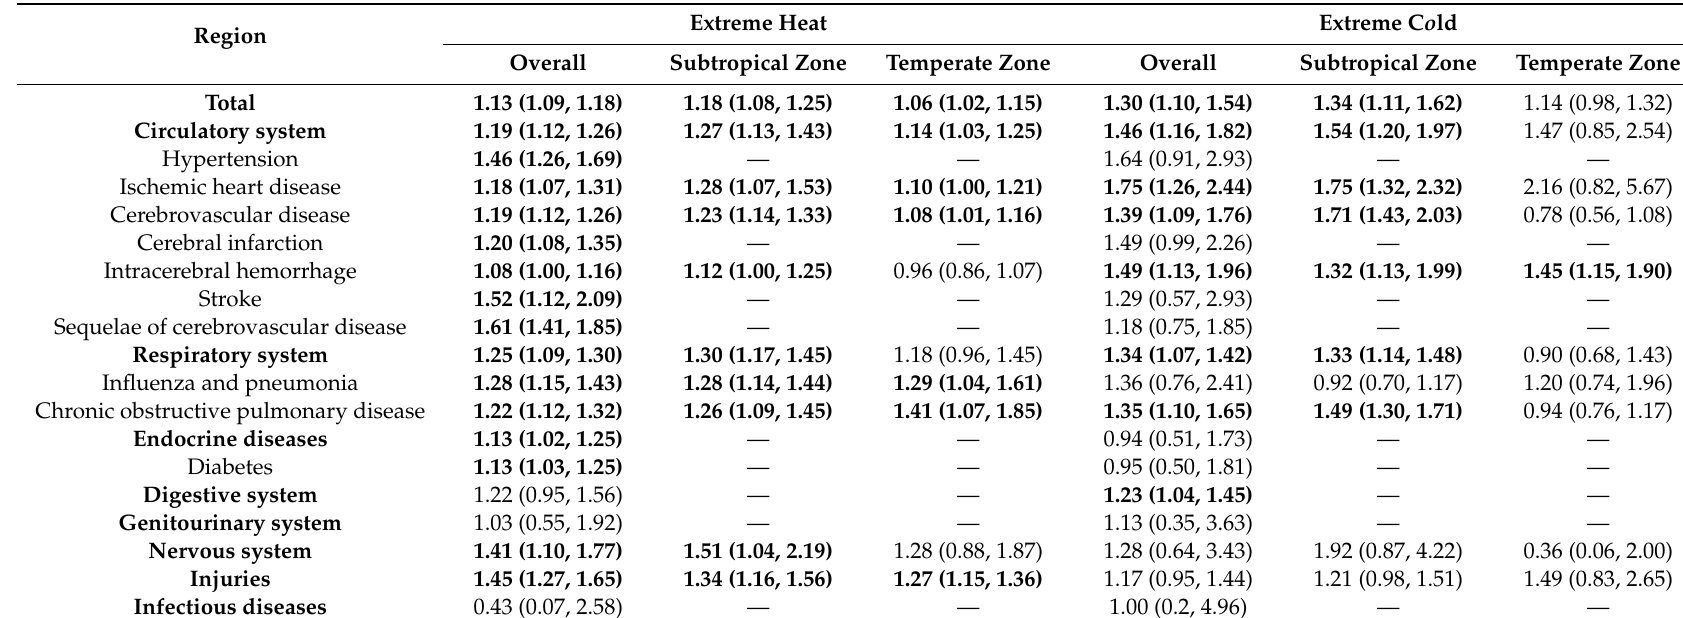
Table 3. Cumulative relative risks of cause-specific mortality due to extreme heat and cold in two regions in